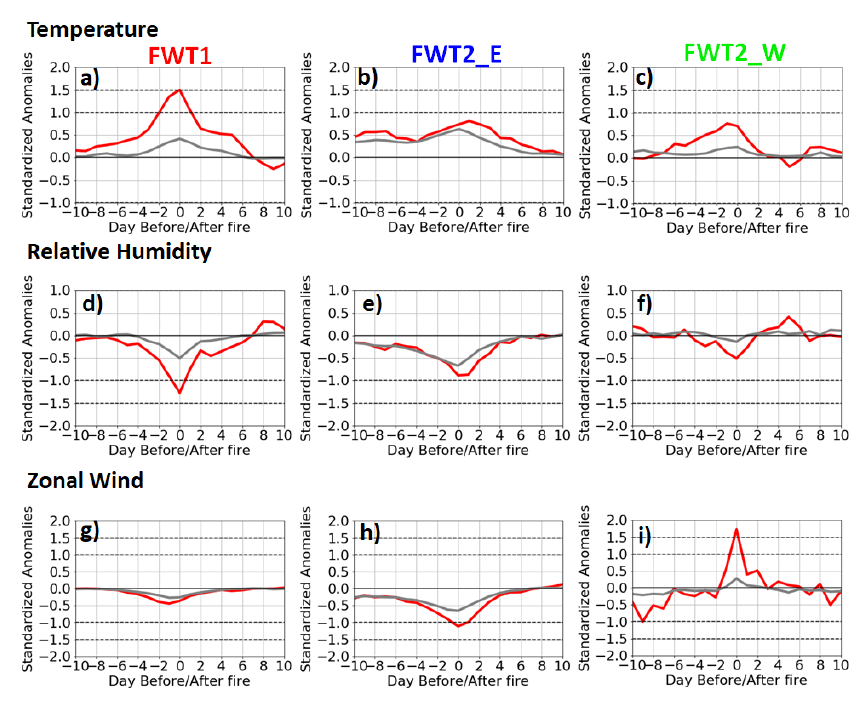
Figure 7. Composites of the standardized anomalies of the (a-c) temperature, (d-f) relative humidity and (g-i) zonal wind at 20 day timescales for all fires (gray) and large fires (red) associated with the three large regions identified in Figure 6 with the same predominant fire weather type.